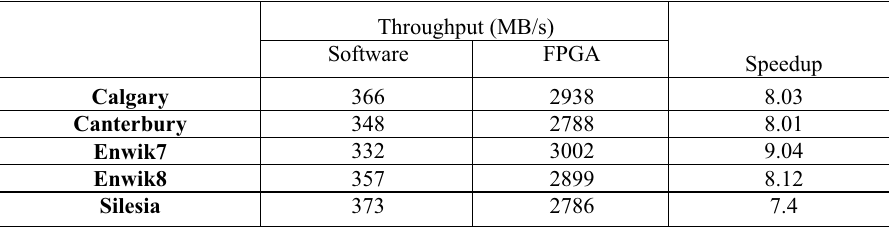
Table 2. Compression speed comparison test